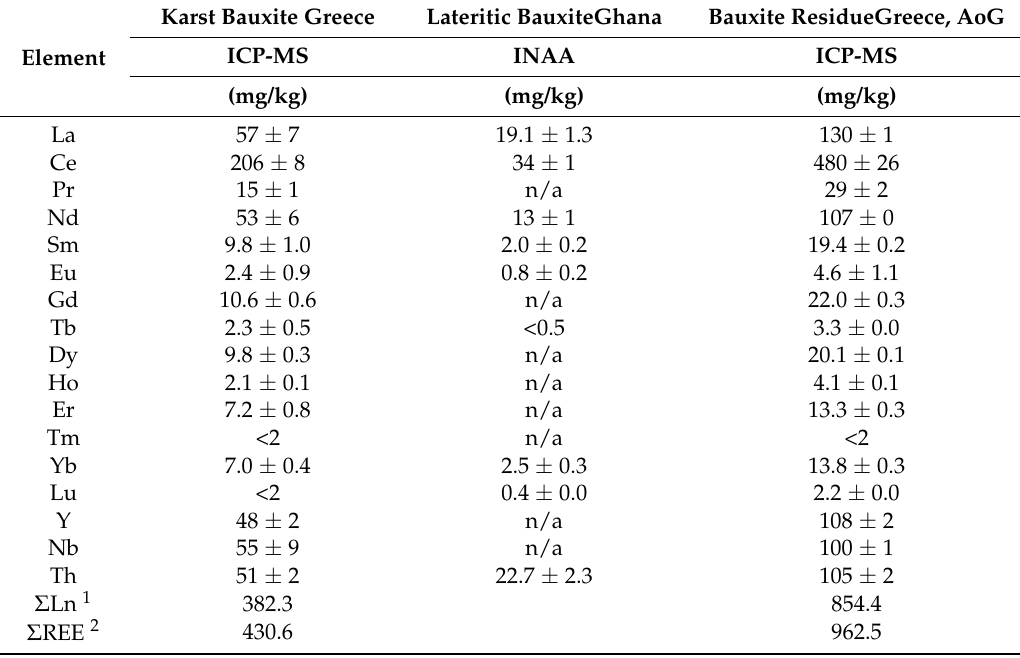
Table 3. Trace element composition of the samples. Error is given as one standard deviation of a duplicate